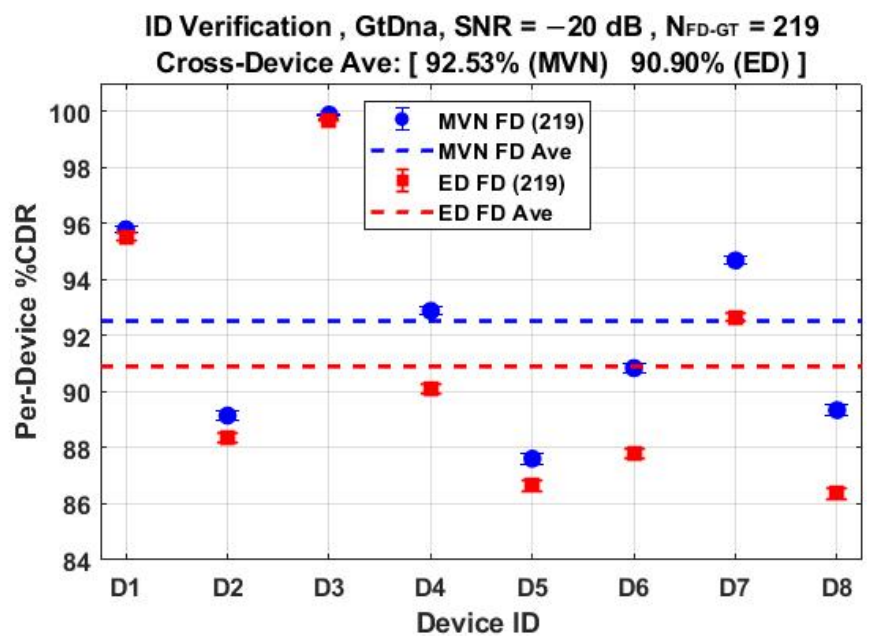
Figure 15. Per-device ID verification performance for full-dimensional N FD-GT = 219 features using the N Mdl = 56 MDA models used for generating %C results in Figure 11. Results generated under SNR = − 20 dB conditions using ED ( ■ ) and MVN ( ● ) measures of similarity.